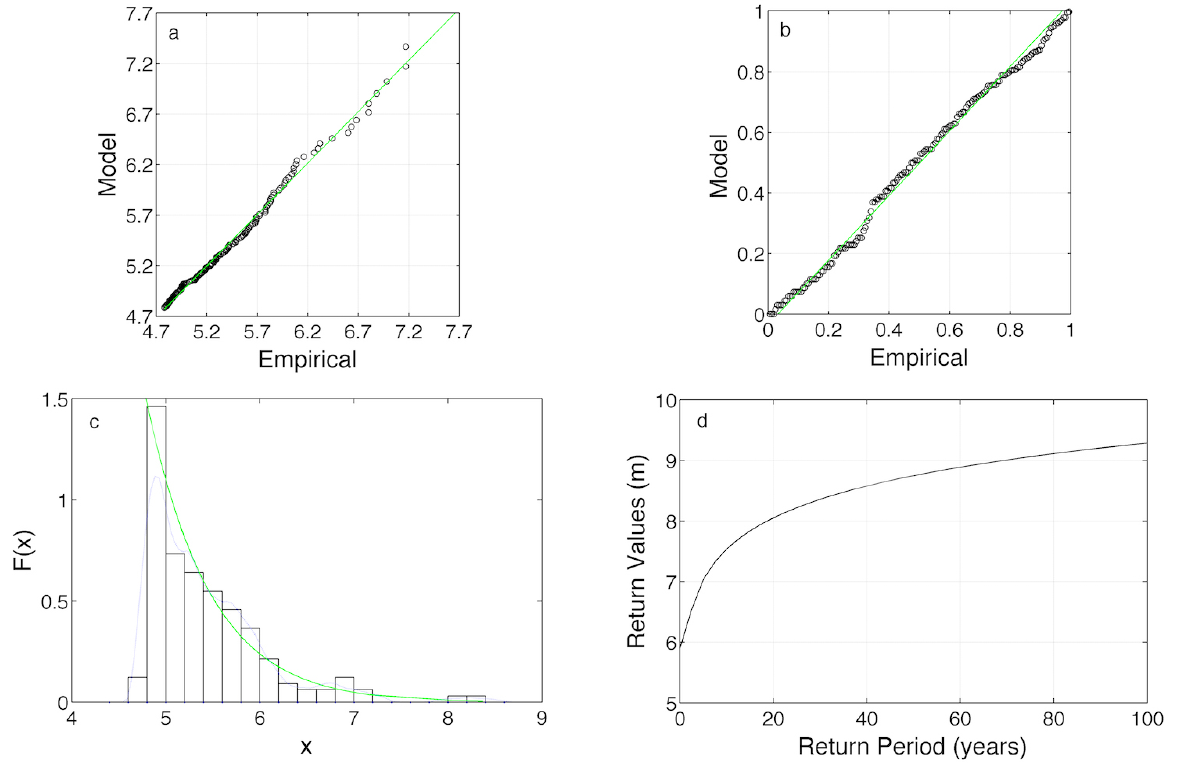
Figure 8. Diagnostic Plots. (a) QQ-plot – empirical values versus GPD modeled points. (b) Probability Plot- empirical values versus GPD modeled points, (c) Density Plot. (d) Return values (meters) versus return periods